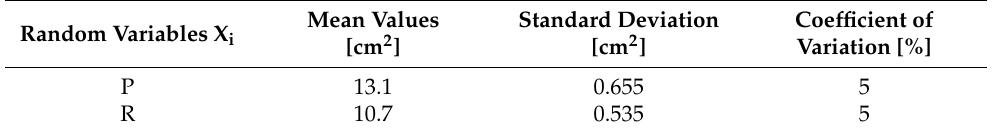
Table 6. Description of random